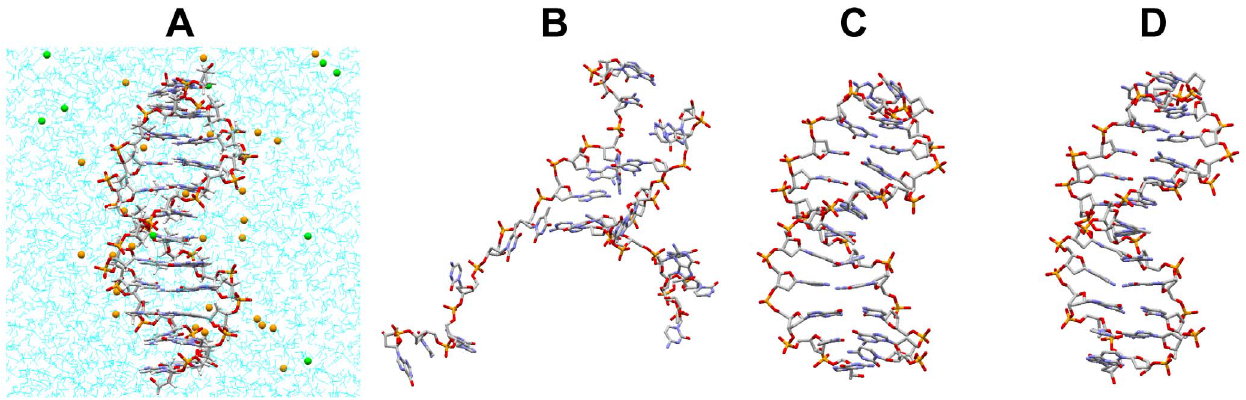
Figure 1. The double-stranded DNA dodecamer system. (A) The initial DNA structure (PDB 1bna) with the explicit TIP3P water molecules (cyan), Na + ions (orange) and Cl 2 ions (green). The atom colors of DNA are the CPK colors. (B) A snapshot at 50 ps by the RESA method with r c =18 A˚. (C) A snapshot at 10 ns by the ZD method, with r c =12 A˚ and a =0.0. (D) A snapshot at 10 ns by the PME method, with r c =12 A˚ and a =0.35 A˚ 2 1 . Hydrogen atoms are not shown in (B) to (D).